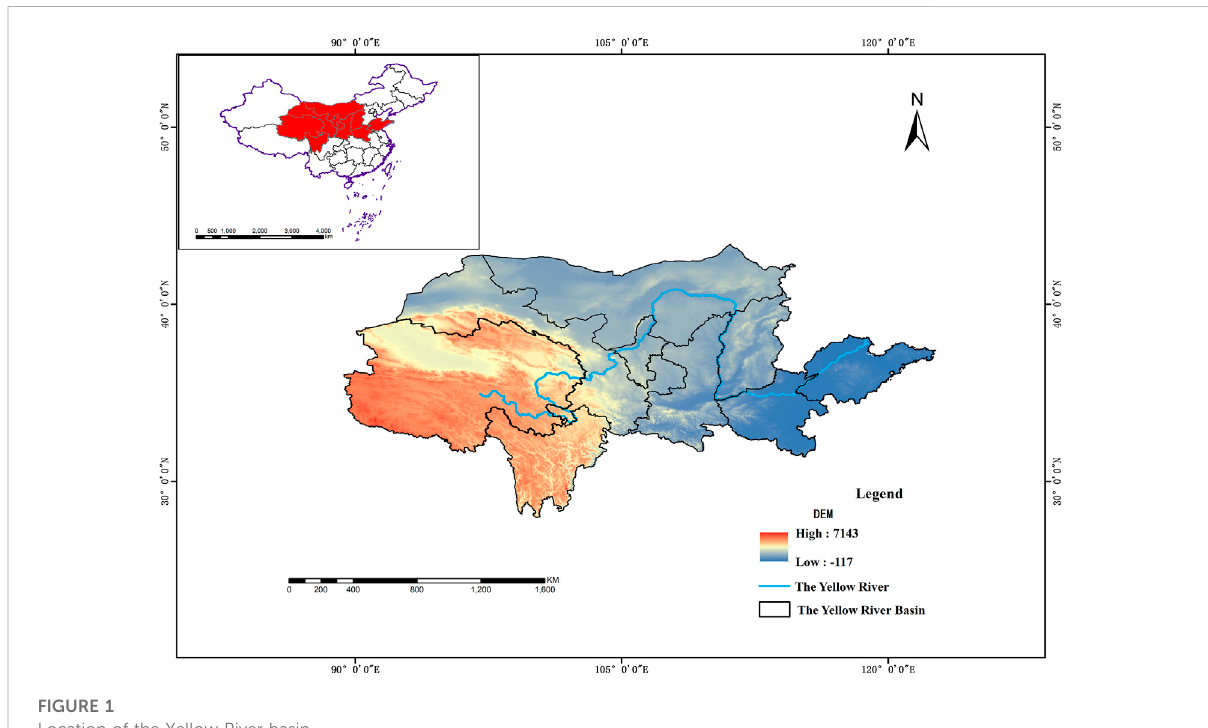
FIGURE 1 Location of the Yellow River